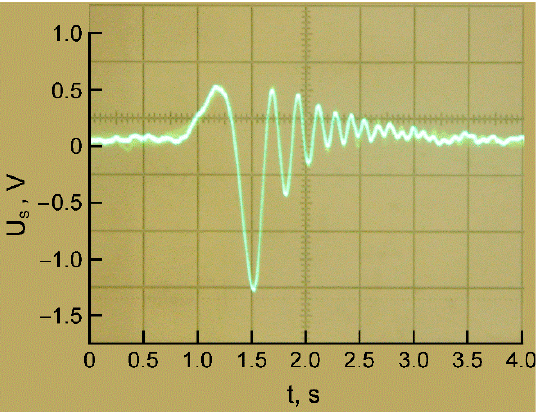
Figure 3. Shape of NMR signal lines at the output of registration circuit 11 from feedwater with inversion of magnetization at f n = 1,435,106 Hz, H 1 = 14.3 A/m.